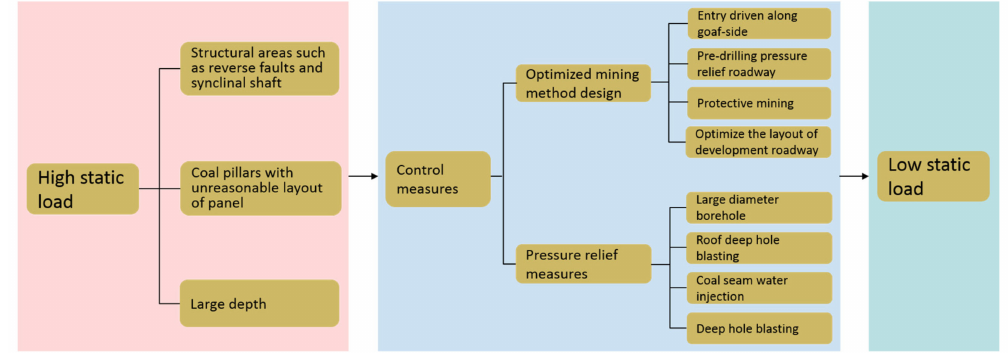
Figure 13. High static load source and control